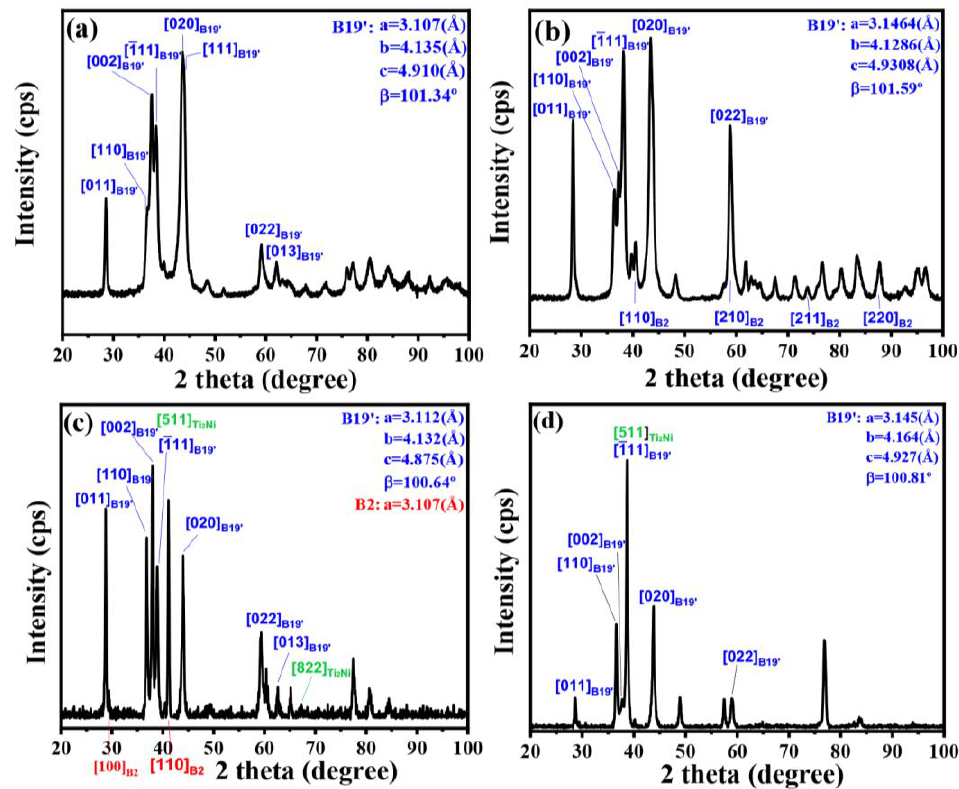
Figure 2. XRD diffractograms of ( a ) Cu15HZ25, ( b ) Cu15HZ30, ( c ) HCu15HZ25, and ( d ) HCu15HZ30.